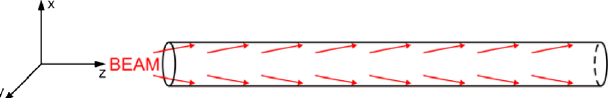
FIG. 1. (Color) A model of the beam-pipe irradiation. X and Y axes are horizontal and vertical axes, respectively, and the Z axis coincides with the beam-pipe longitudinal axis that coincides with the beam axis. The beam propagates in the Z